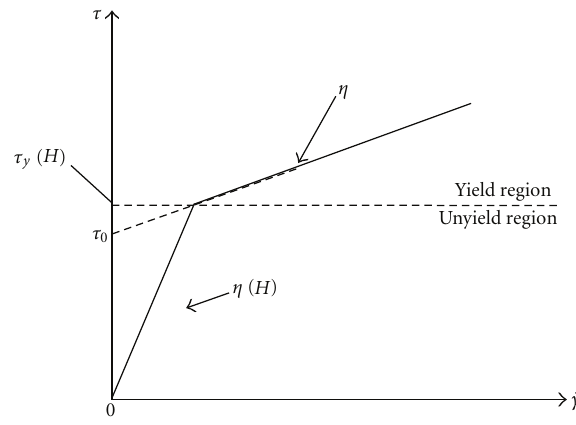
Figure 3: Biviscosity model of MR